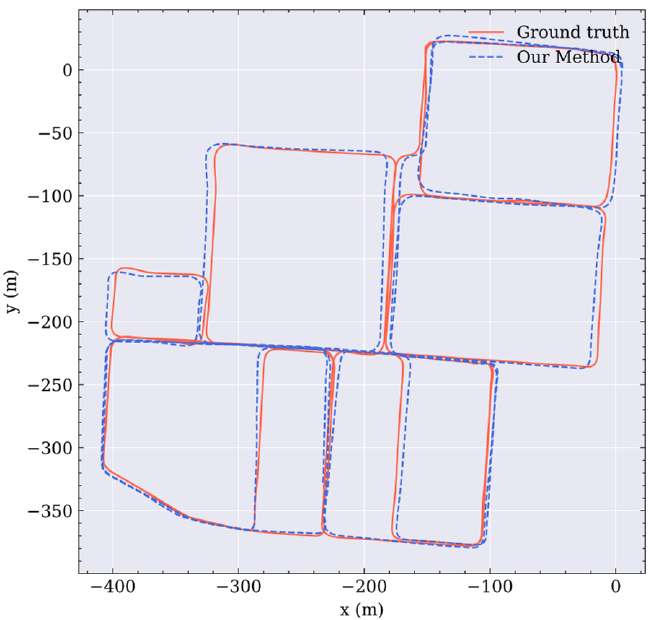
Figure 9. Trajectory and ground truth of the Wuhan Research and Innovation Center dataset.